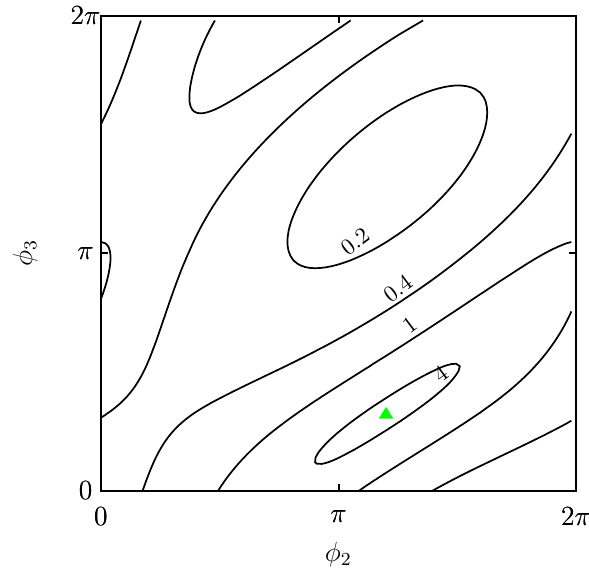
Fig. 8 Sensitivity of the p → K + ¯ ν lifetime to the GUT phases (φ ,φ ) for the CMSSM parameter choices tan β = 5 , A 2 3 3 , m 0 = 14 . 13 TeV and m 1 / 2 = 9 . 79 TeV in units of 10 33 years. The maximum value of the lifetime is indicated by a green triangle